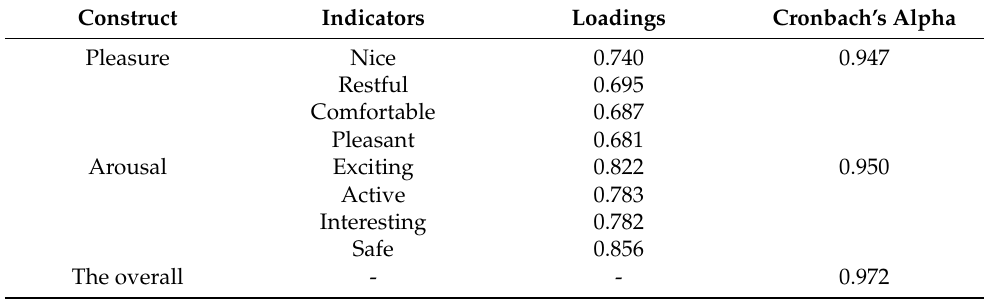
Table 2. Factor loadings for each